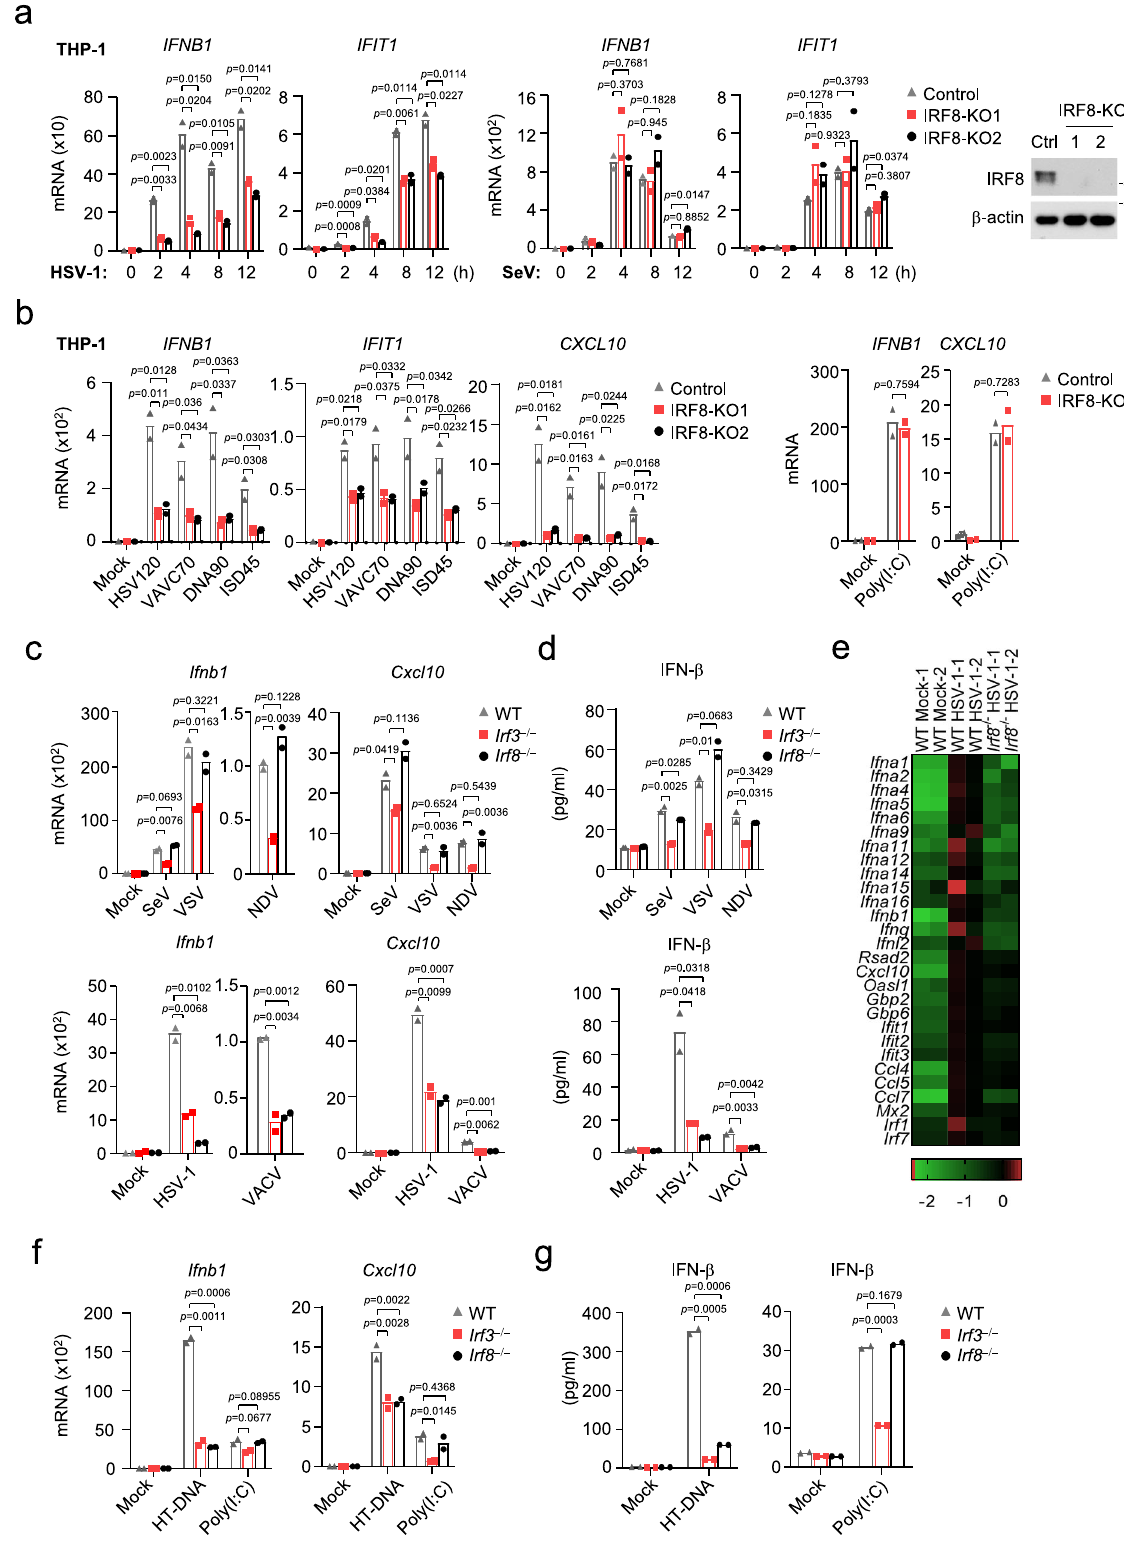
cell (BMDC) (Fig. S1c), suggesting that Irf8 plays a conserved function in DNA virus-induced activation of Sting-Irf3 axis in different immune cells. Recent studies have reported that Sting-mediated autophagy does not depend on phosphorylation of its S365 47 . We found that Irf8- de fi ciency impaired cGAMP-induced phosphorylation of Sting S365 and Irf3 S388 in BMDMs but had no effects on cGAMP-induced LC3